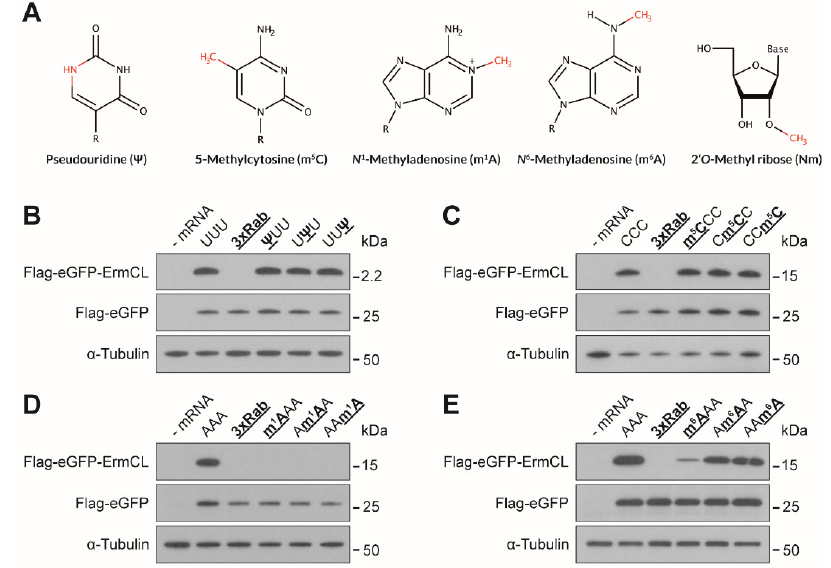
Figure 1. Translation efficiency and accuracy of site-specifically modified mRNA nucleotides. ( A ) The nucleotide derivatives that were investigated are depicted. The chemical groups differing from the standard nucleotides are displayed in red. ( B – E ) Western blot analyses of modified mRNAs harboring ( B ) pseudouridine ( Ψ ), ( C ) 5-methylcytosine (m 5 C), ( D ) N 1 -methyladenosine (m 1 A), and ( E ) N 6 -methyladenosine (m 6 A) translated in HEK293T cells. An unmodified eGFP mRNA was employed as an internal transfection control and α -tubulin as a loading